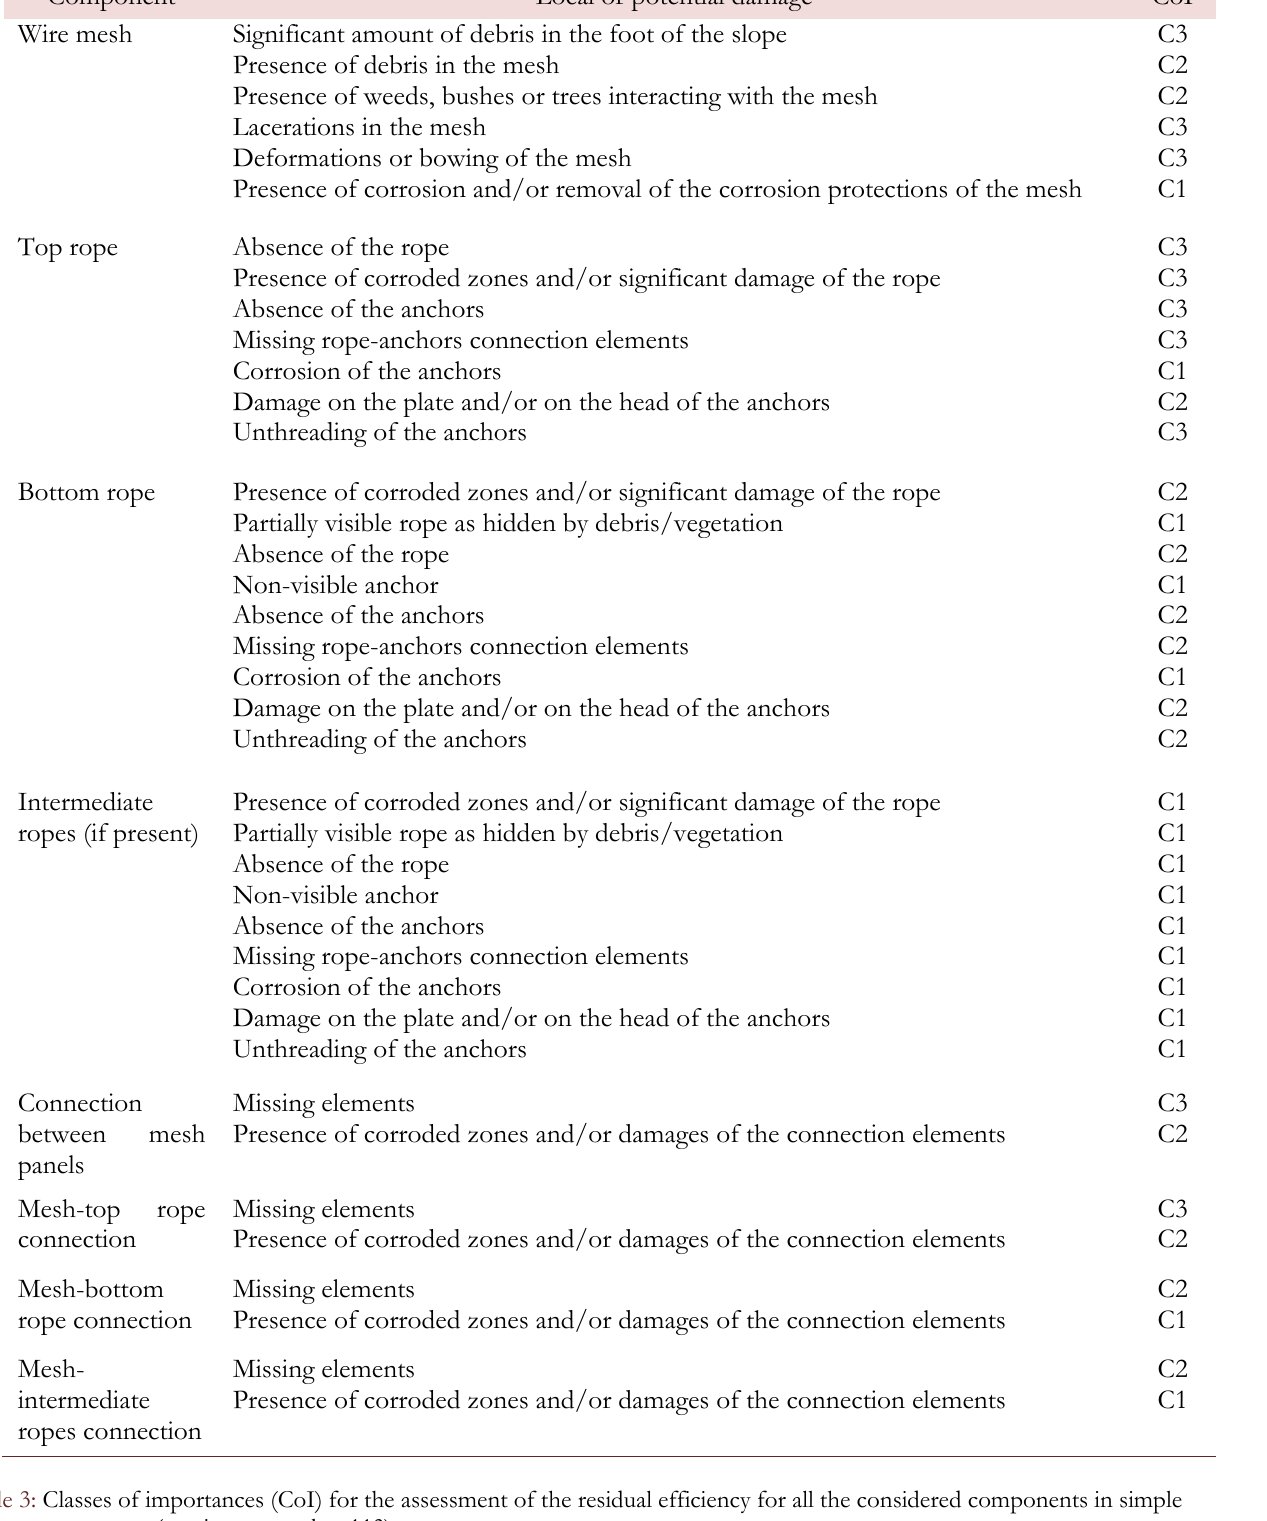
Table 3: Classes of importances (CoI) for the assessment of the residual efficiency for all the considered components in simple drapery net systems (maximum equal to